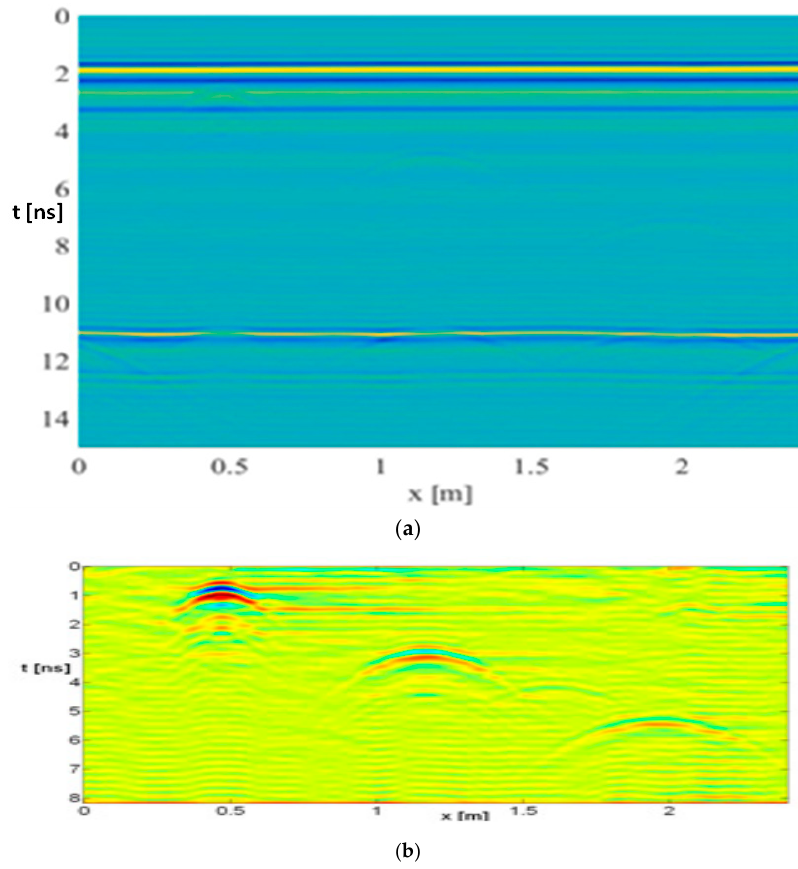
Figure 8. The experimental radar data, in time domains, after free-space response removal ( a ), and after further ( b ) zero timing and background removal. In the lower image, a time cut has also been done, in order to focus on the depth range of interest.